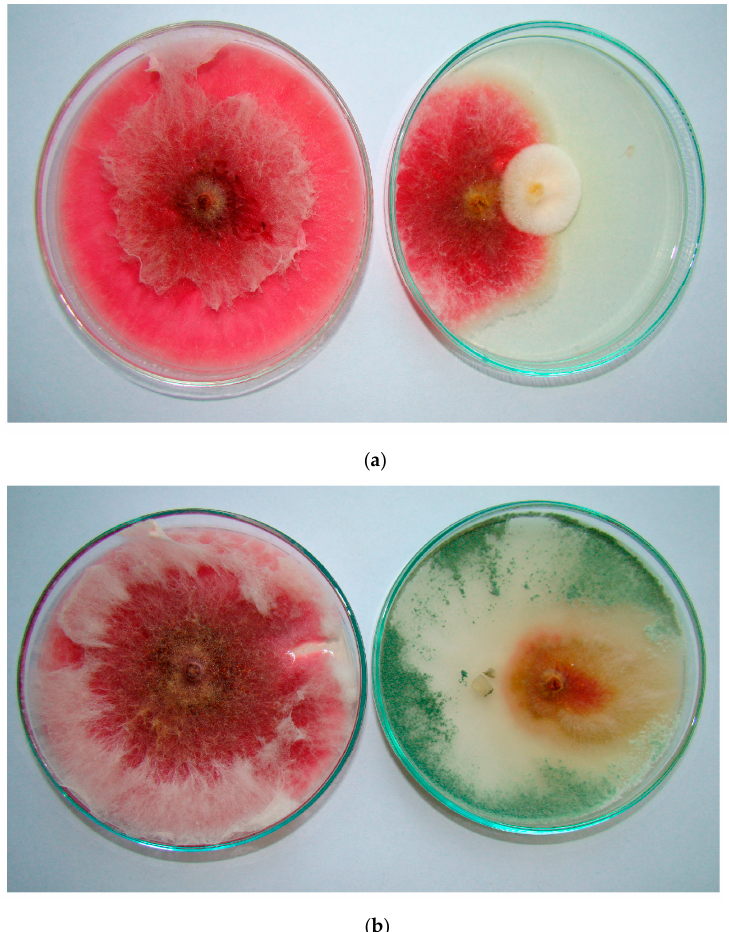
Figure 5. 10-day-old colonies of fungi on the potato dextrose agar (PDA) medium: ( a ) On the left— Fusarium culmorum , on the right— Fusarium culmorum with Clonostachys rosea ; ( b ) on the left— Fusarium culmorum , on the right— Fusarium culmorum with Trichoderma sp.; (photo by E. Patkowska).